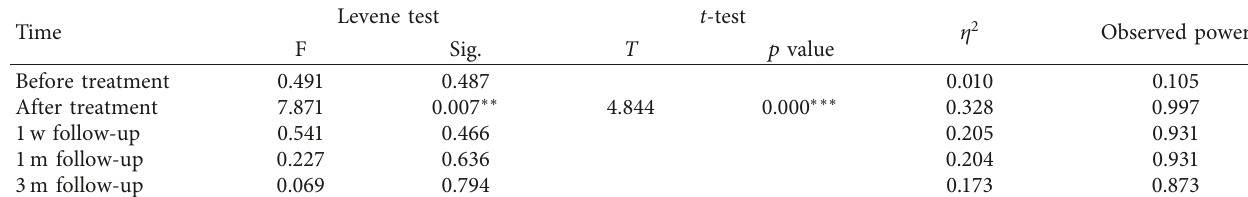
Figure 3: Mean CMS scores between the TPRF and the TENS Table 2: Independent t -test for CMS for Groups TPRF and TENS.